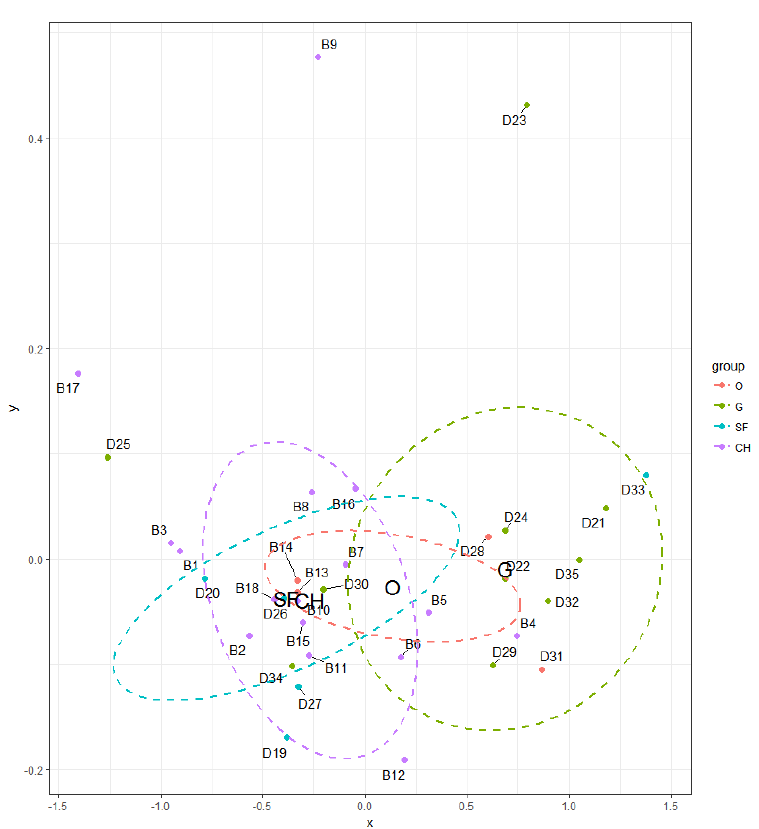
Figure 18. NMDS visualizing the level of similarity for the factor—type of heating.